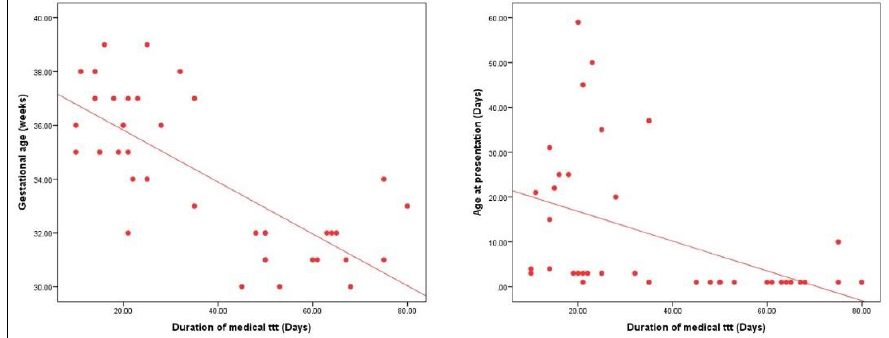
Figure 2: Graph showing the relation between gestational age and duration of medical treatment (Left image), and the relation between age at presentation and duration of medical treatment (Right image).